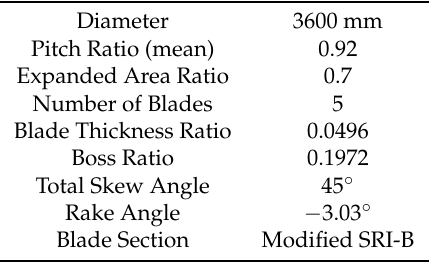
Table 1. Main particulars of the highly skewed Seiun–Maru propeller.